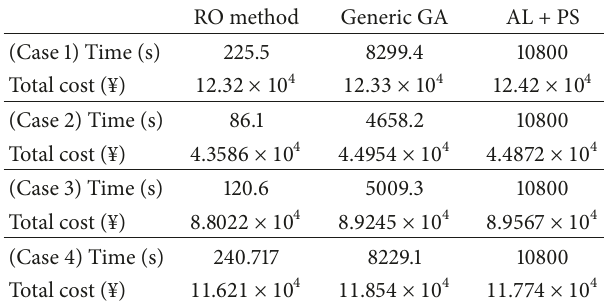
Table 6: Computational performances for different